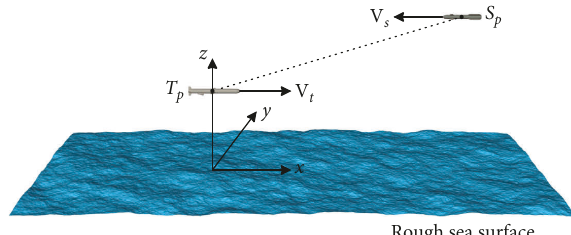
Figure 8: The schematic diagram of the target and environment